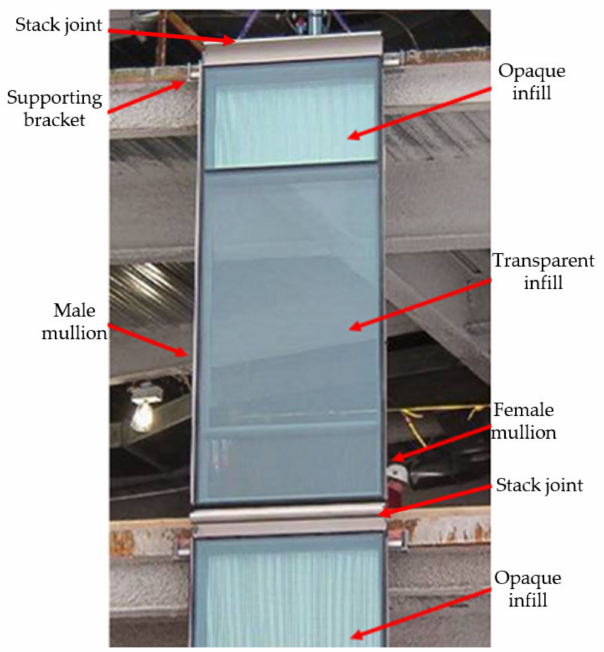
Figure 1. Typical curtain wall unit.